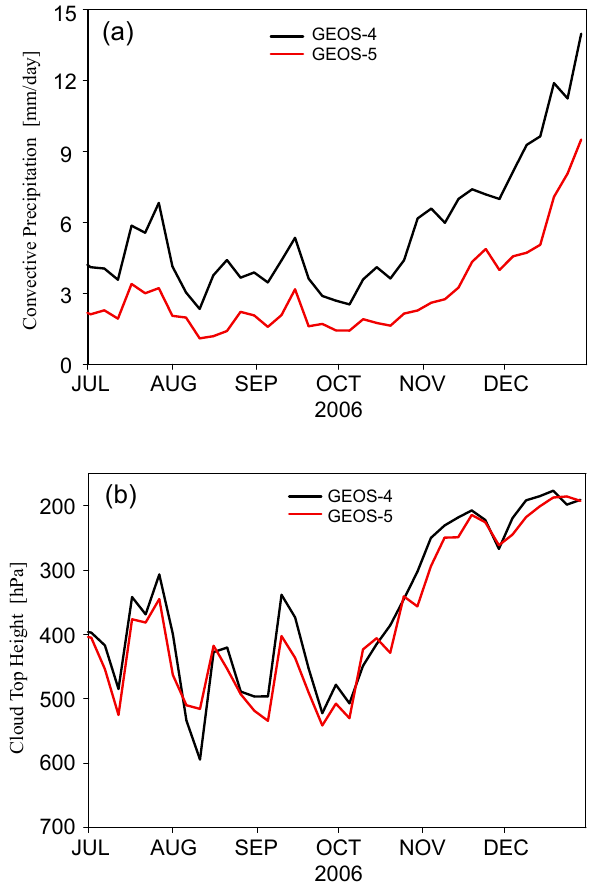
Fig. 13. GEOS-4 and GEOS-5 (a) deep convective precipitation rates and (b) cloud top height for July–December 2006 over the western and central Indonesian domain (see Fig. 1). Values are 5- day